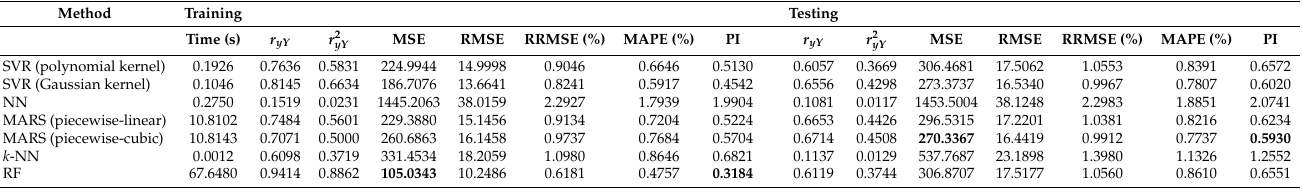
Table 10. Performance of the machine learning in melt temperature prediction based on static data (lime and dolomitic lime added as supplementary